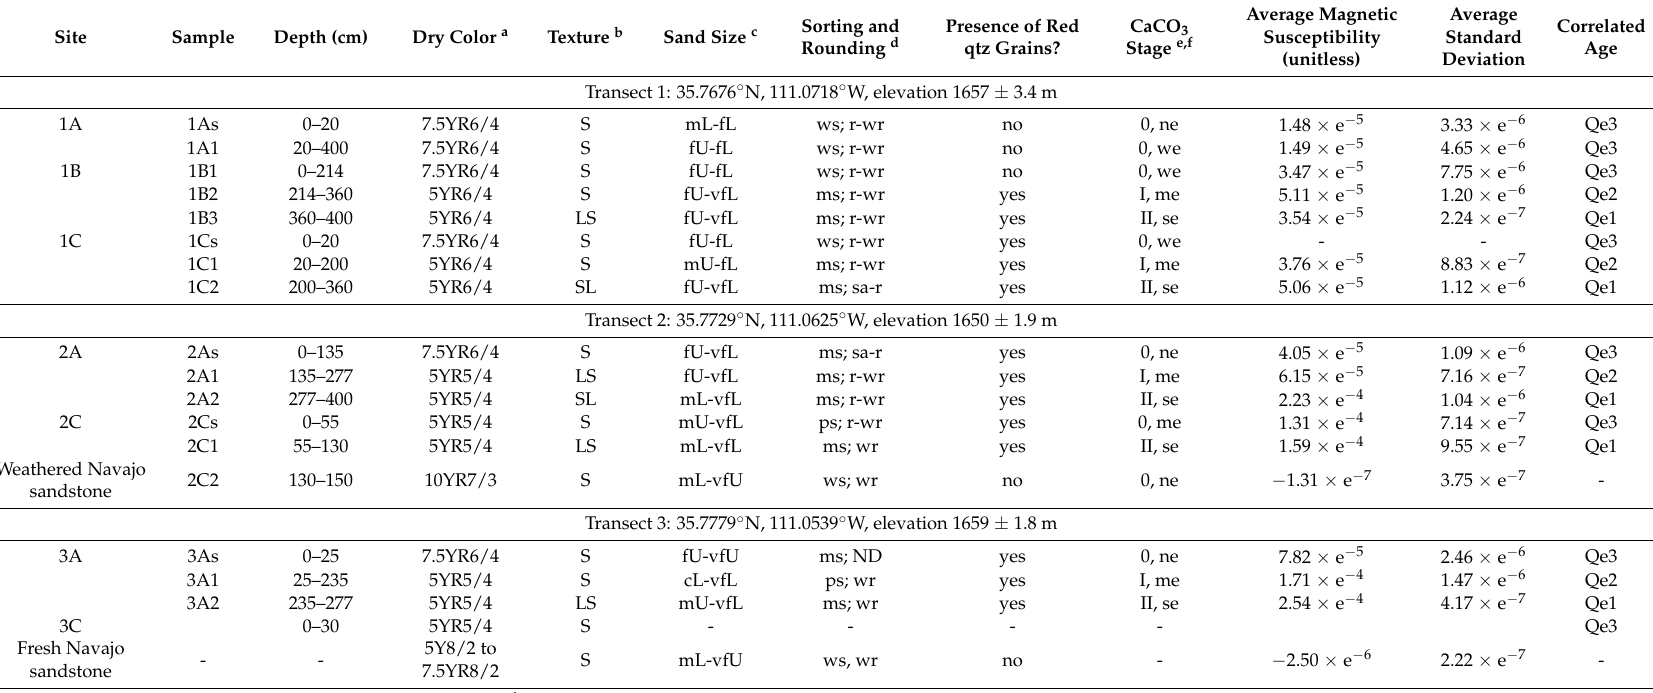
Table 1. Gold Springs linear dune coring and magnetic susceptibility experiment results. Within the <2 mm fraction, samples were greater than 95% quartz and all quartz grains were frosted. Magnetic susceptibility analyses were performed using an AGICO MFK1 kappabridge at the Paleomagnetism Laboratory at the University of New